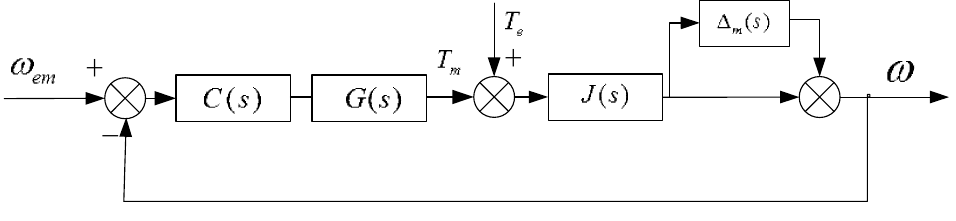
Figure 10. Control block diagram of the load simulation system.